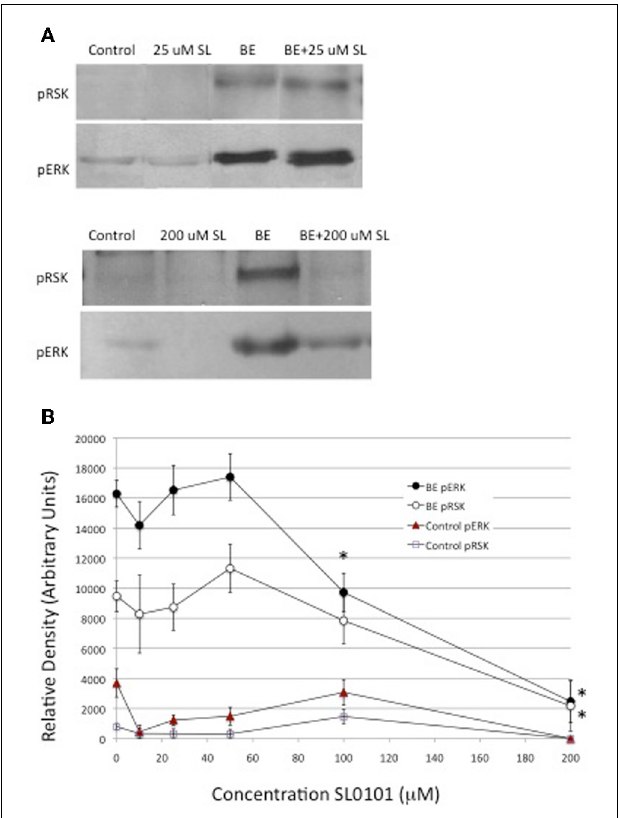
FIGURE 8 | Effects of RSK inhibitor (SL0101) on protein phosphorylation. Western blots were prepared from prothoracic glands described in Figure 7 . Cellular lysates were probed for phosphoproteins via Western blots. (A) Results of a typical experiment. (B) Quantification of Western blots. Asterisks indicate groups that were statistically greater than their respective no-hormone controls (ANOVA, Tukey–Kramer post-hoc test). Sample sizes were as follows (replicates per group): Control = 28; BE = 28; 10uM SL = 2; 25uM SL = 7; 50uM SL = 3; 100uM SL = 15; 200uM SL = 2; BE + 10uM SL = 2; BE + 25uM SL = 10; BE + 50uM SL = 6; BE + 100uM SL = 13; BE + 200uM SL = 6.